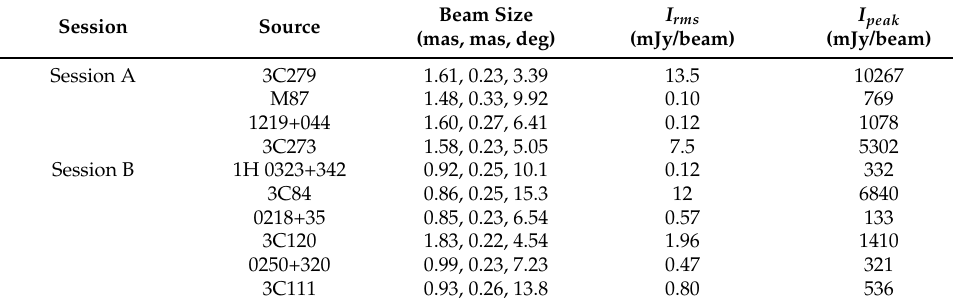
Table 5. Summary of image parameters of Figures 5 and